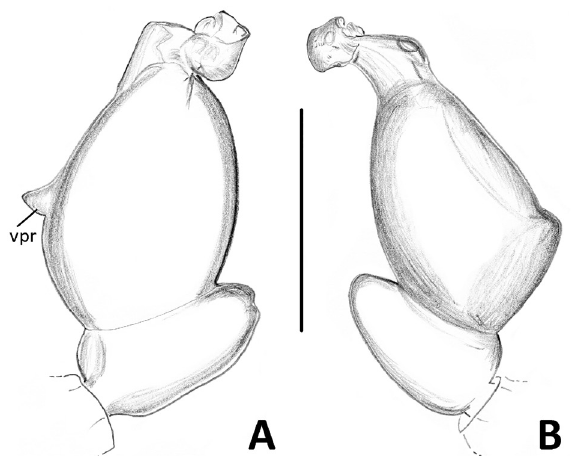
Figure 7. Ischnothyreus chippy n. sp., male from a forest be- tween Koslanda and Beragala: A , left palp, retrolateral view; B , same, prolateral view. Abbreviation: vpr, ventral protuber- ance. Scale bars: 0.1